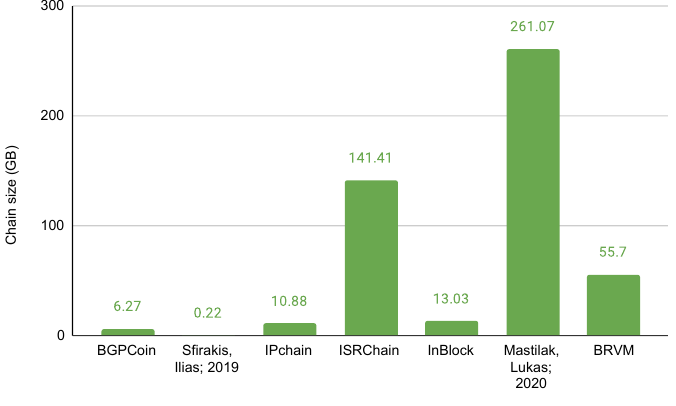
Figure 5. The comparison of storage size